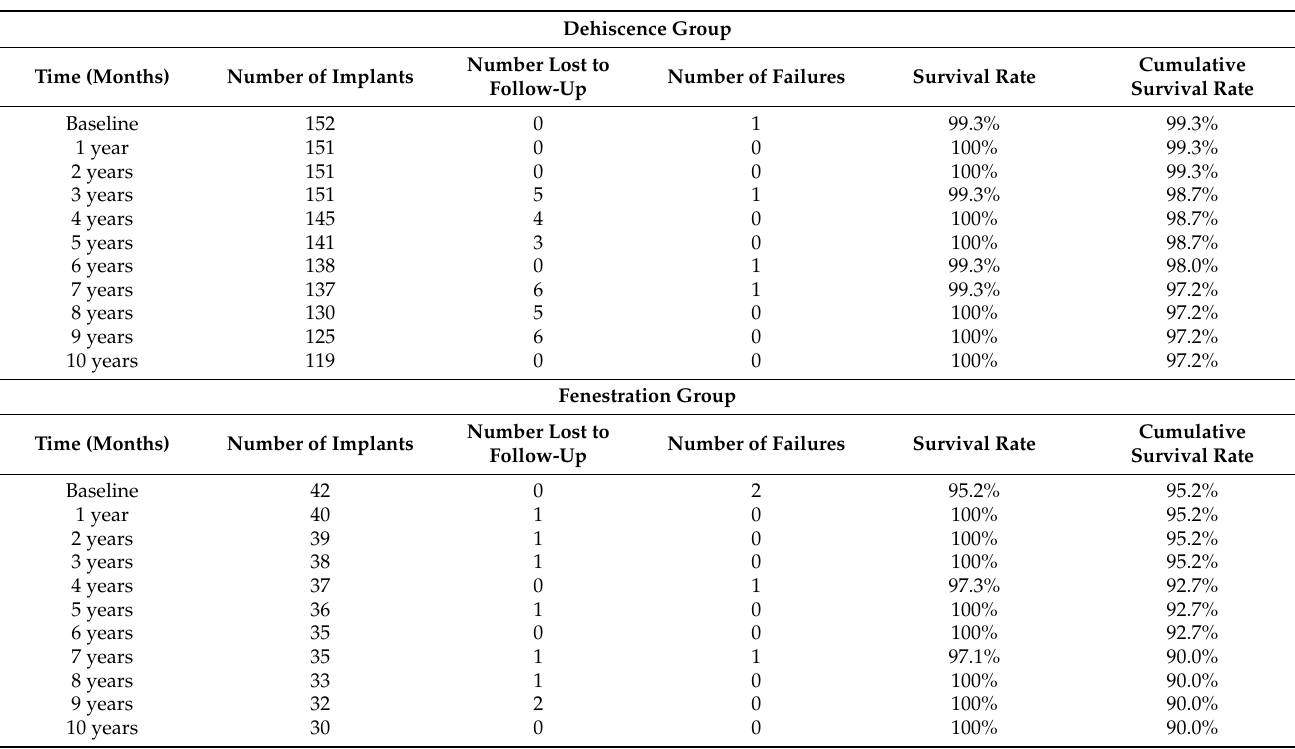
Table 4. Life tables for cumulative implant survival rate using the implant as the unit of analysis: dehiscence and fenestration groups.